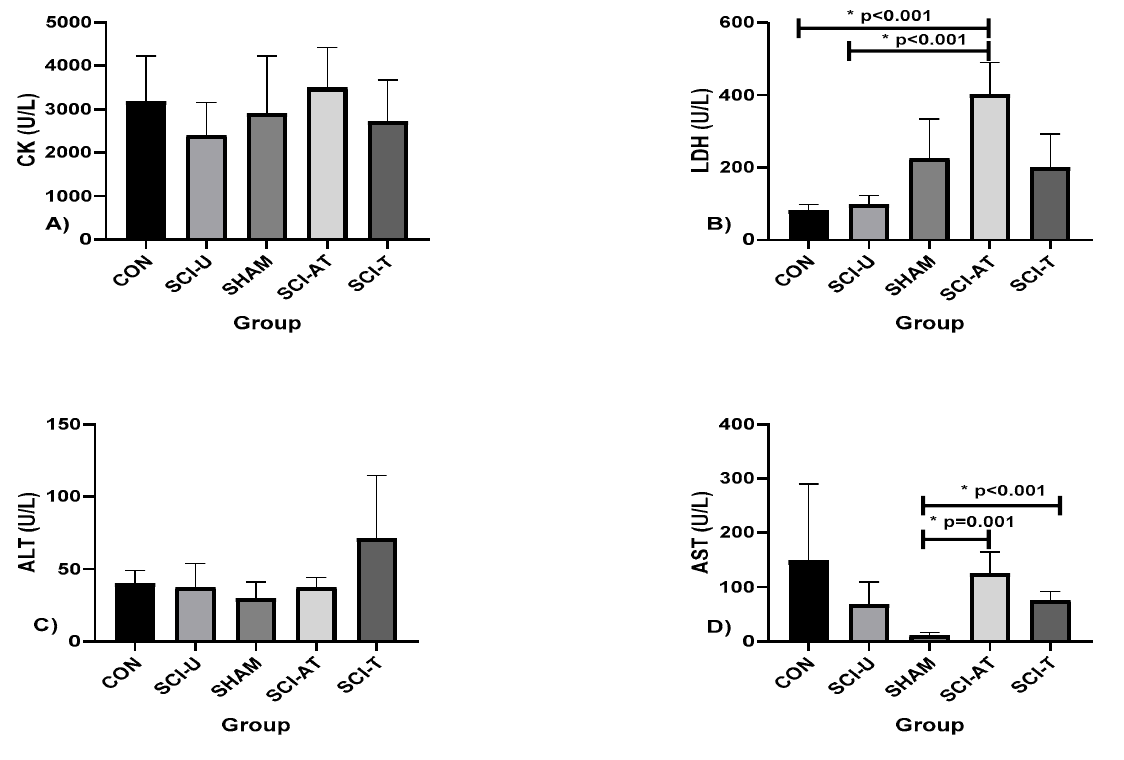
Figure 1. Muscle Damage levels presented by ( A ) Creatine Kinase (CK), ( B ) Lactate Dehydrogenase (LDH), ( C ) Alanine Aminotransferase (ALT), ( D ) Aspartate Aminotransferase (AST) after interven- tions in the different groups: Control (CON), constituted by rats not exposed to any surgical procedure or treatment, Sham (SHAM), surgical control animals submitted to laminectomy surgery without SCI, SCI Untrained group (SCI-U), animals that underwent partial transection but were untrained, SCI Trained group (SCI- T), animals that underwent partial transection and were trained, SCI Active Trained group (SCI- AT), animals that trained previously, underwent partial transection and were trained again. * p < 0.05 ANOVA (one-way), and Bonferroni post hoc. There was no difference in CK and ALT among the groups. In relation to the LDH there was difference between CON and SCI-U, and in relation to SCI-AT groups ( p < 0.001, F(4,28) = 88.118; η 2 p = 0.926, very high effect). Regarding AST levels, there were differences between SHAM and SCI- AT groups ( p = 0.001) and SCI-T ( p < 0.001; F(4,28) = 5.275; η 2 p = 0.433, high